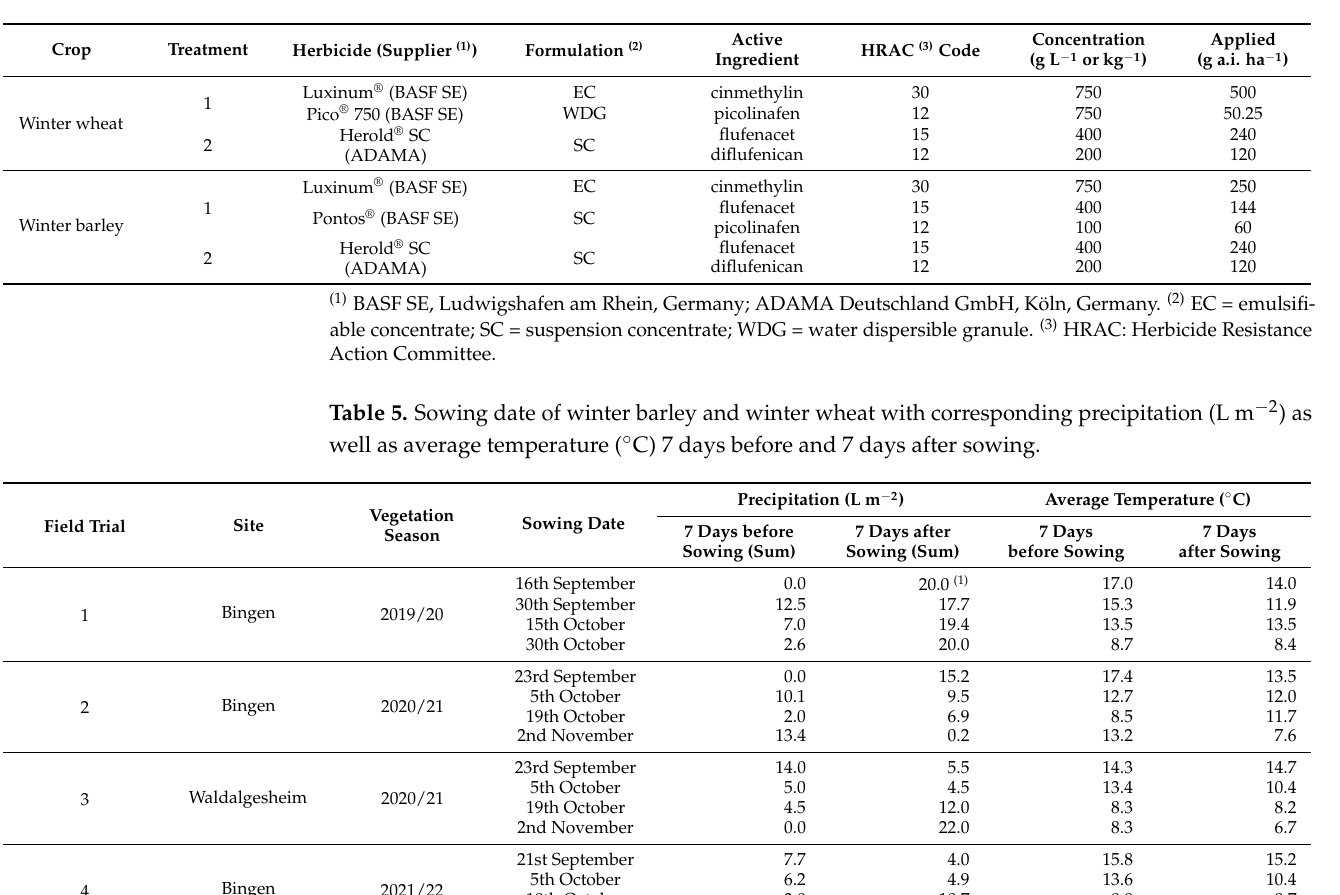
Table 4. Used herbicide in winter wheat and winter barley in all field trials.